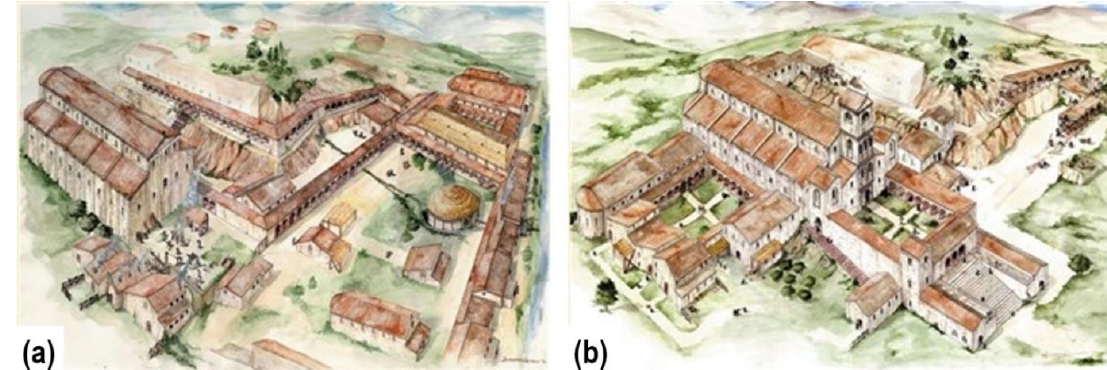
Figure 2. ( a ) Reconstructive hypothesis of the monastery during the early Middle Ages; ( b ) reconstructive hypothesis of the monastery during the late Middle Ages (drawings by S. Carracillo, both available on www.sanvincenzoalvolturno.it, accessed on 29 June